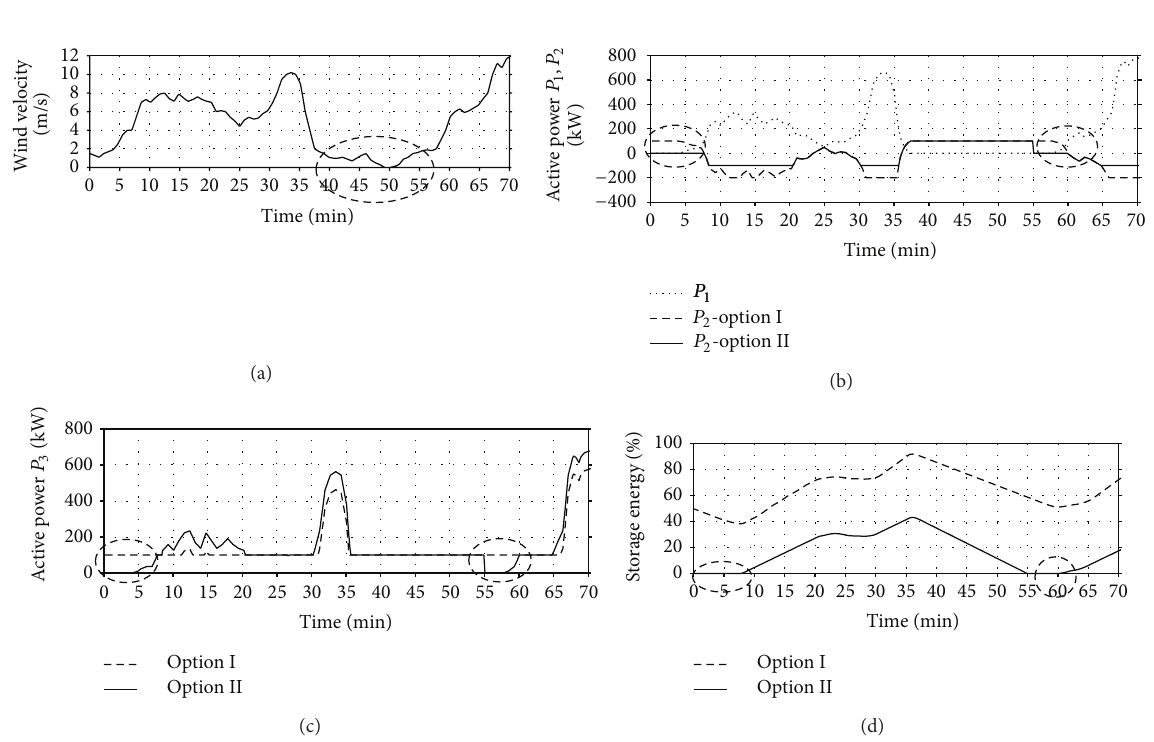
= 𝑓(𝑡) and options I and WT ES %